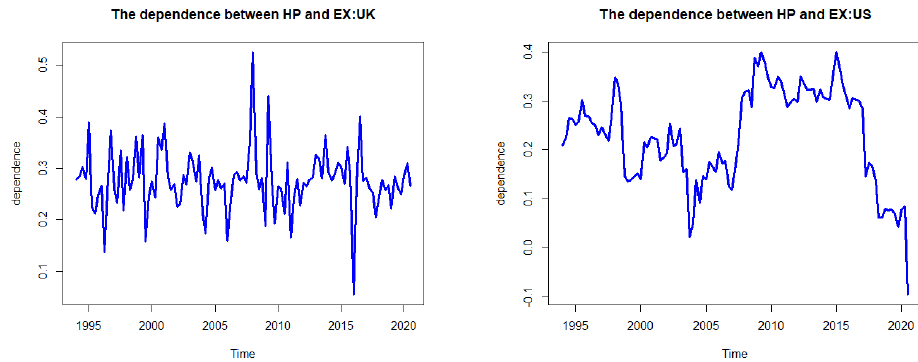
Figure 1. The dependence between house prices and exchange rates in OECD countries.